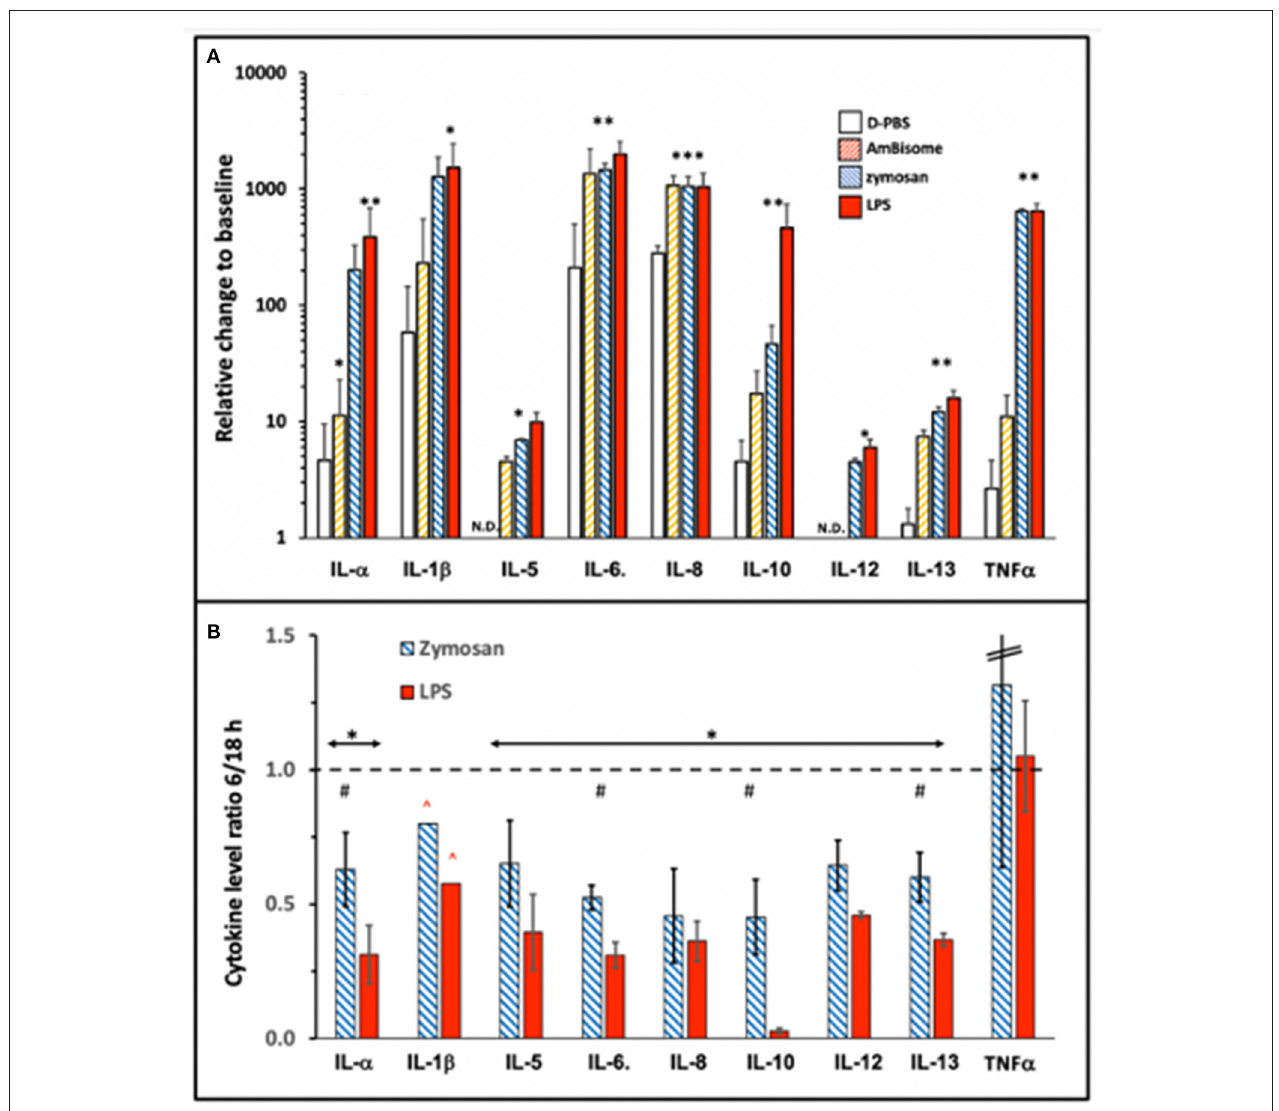
FIGURE 3 | Cytokine induction by immune stimulants that also activate complement. AmBisome, zymosan and LPS were applied at 1.98mg phospholipid/ml, 0.5 mg/ml and 0.5 µ g/ml, respectively, and the PBMC supernatants were analyzed for cytokine levels after 6 and 18h incubation. (A) Shows the cytokine levels expressed as ratios, relative to 0min baseline at 18h, while (B) shows the ratios of 6h readings relative to 18h only for zymosan and LPS. Other details are the same as described for Figures 1 and 2 . The bars show the mean ± SD ( n = 3); * and ** indicate statistically significant increases comparing to D-PBS; P < 0.05 or 0.01, respectively; # , undetectable rises. (B) , * and # indicate statistically significant decrease using one-tailed T -test comparing to 1, or between the two columns, respectively ( P < 0.05); ∧ indicates higher real value since data point(s) was/were out of the detection range of the